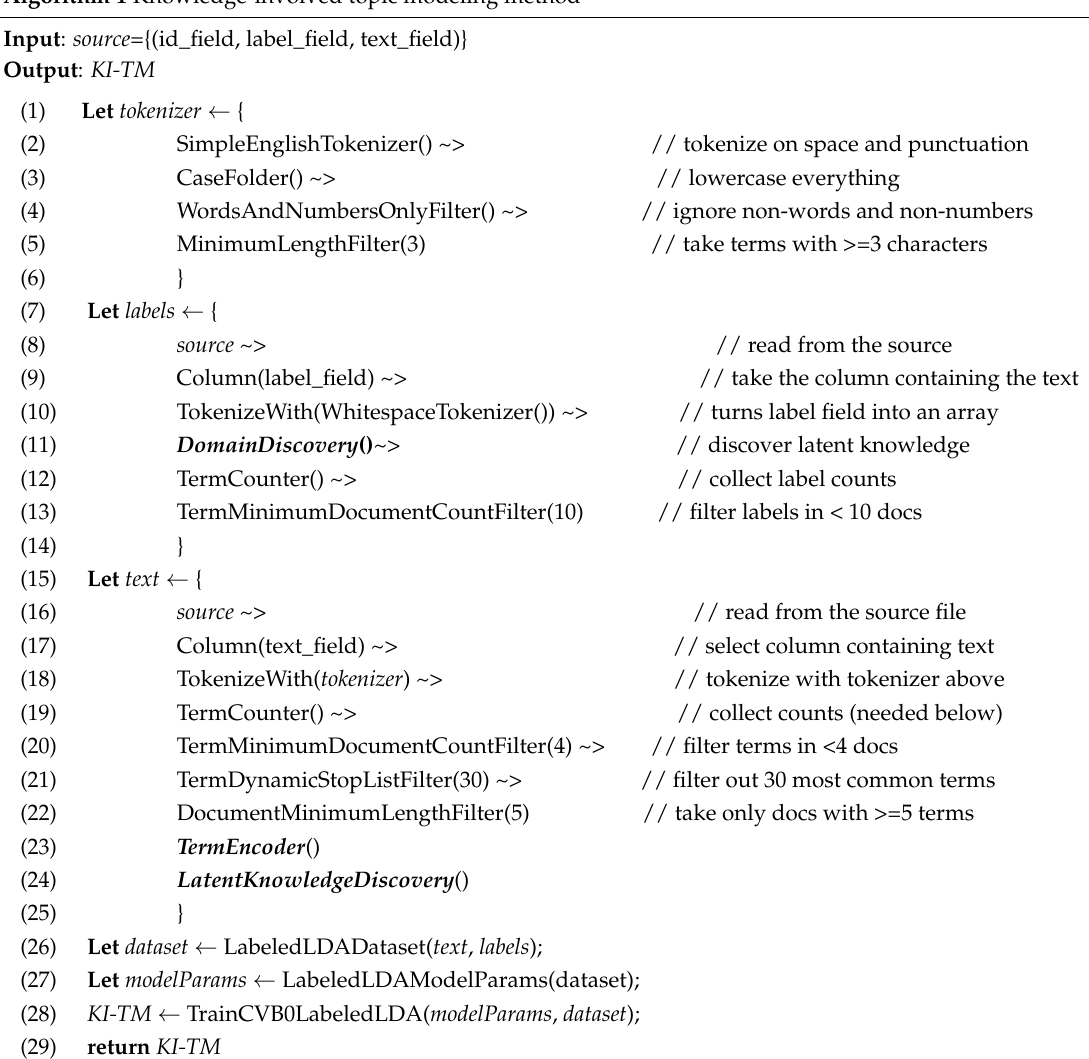
Algorithm 1 Knowledge-involved topic modeling